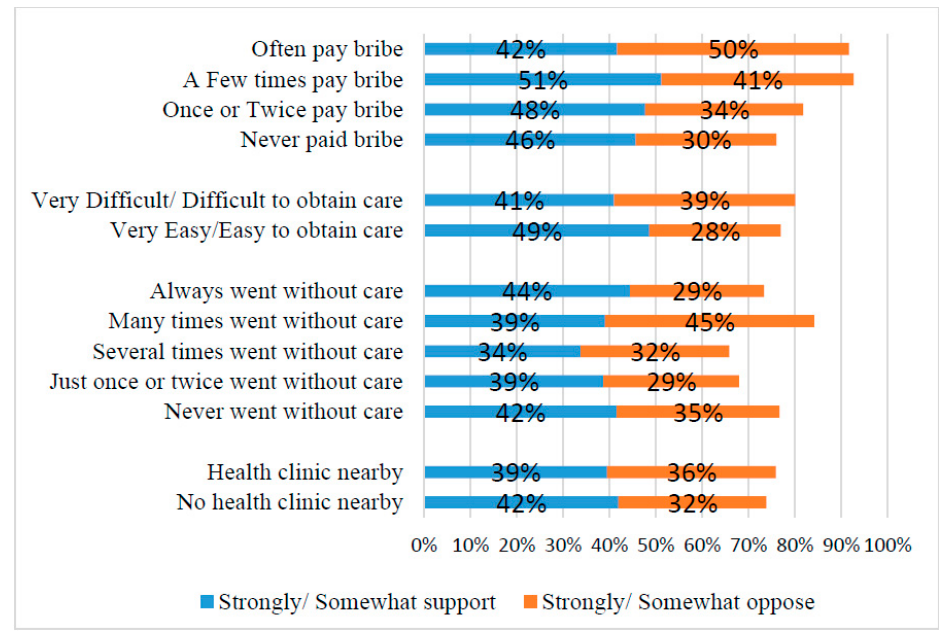
Figure 5. Support for higher taxes/fees and access to health services; Source: Author’s construct.